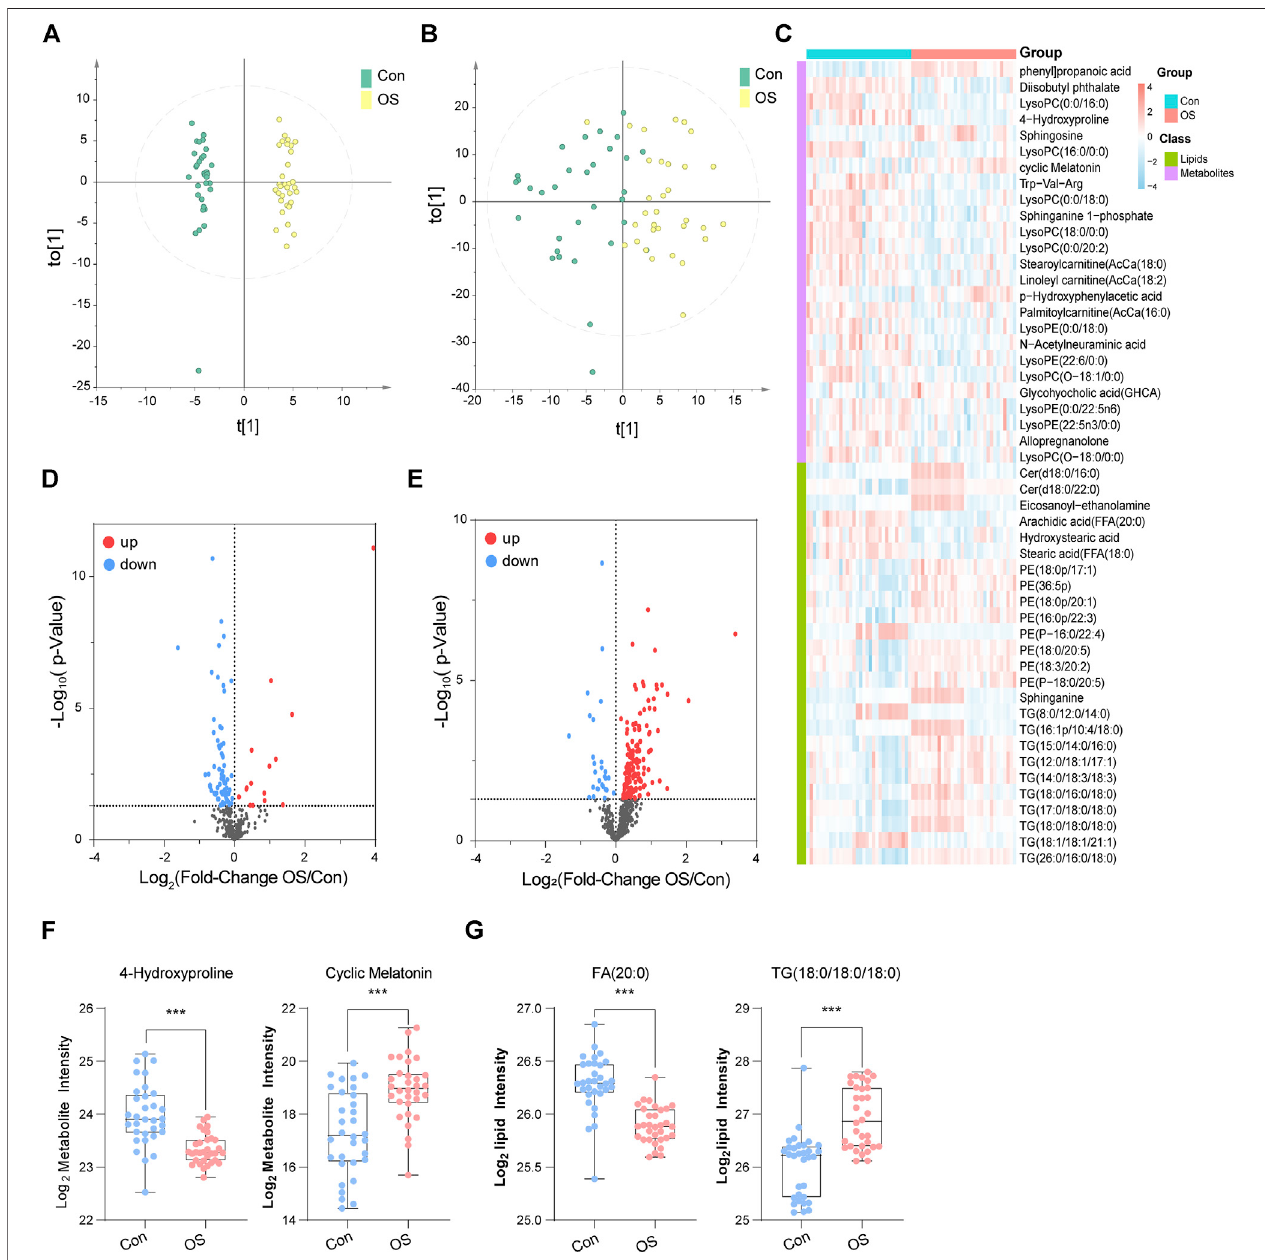
FIGURE 2 | OPLS-DA score plots of metabolites (A) and lipids (B) . In the heatmap, blue indicates lower relative intensity, and red indicates higher relative intensity (C) .Thereddotsofthemetabolites (D) andlipids (E) inthevolcanoplotsindicatedanincreaseintheOSgroup,andthebluedotsindicateadecrease.4-Hydroxyproline and cyclic melatonin were representative metabolites (F) . FA (20:0) and TG (18:0/18:0/18:0) were representative lipids (G) .